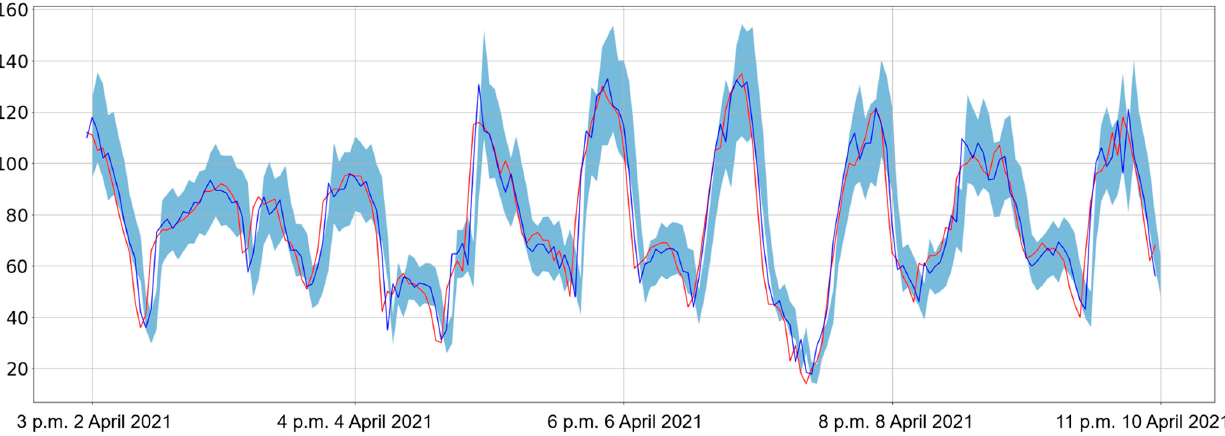
Figure 8. Forecasting results of O 3 concentration in Beijing.